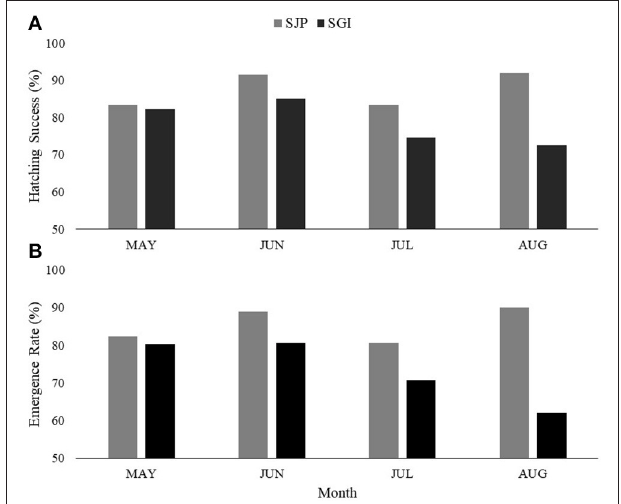
FIGURE 2 | Average (A) hatching success and (B) emergence rate at T.H. Stone Memorial St. Joseph Peninsula (SJP) (gray) and St. George Island (SGI) (black) for each month (May–August) throughout the years (2013–2016) considered in this study.